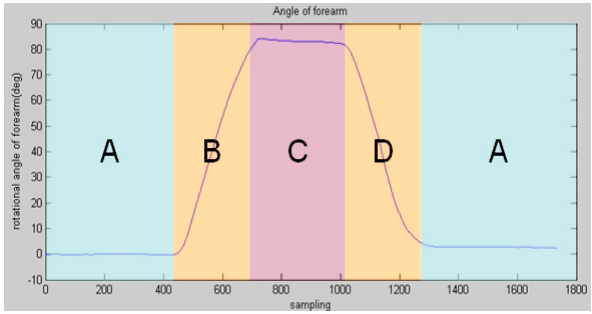
Figure 4. Motion of the subject’s forearm detected by an inertia sensor.